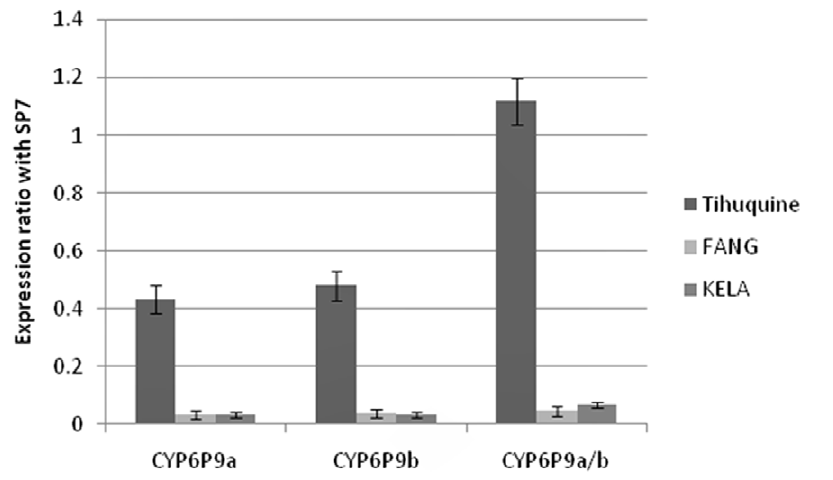
Figure 5. Relative expression levels of candidate genes using quantitative RT-PCR. Comparison of the patterns of gene expression of each copy of the duplicated CYP6P9 ( CYP6P9a and CYP6P9b ) and when both are amplified together ( CYP6P9a/b ) between the resistant field sample of Tihuquine, the laboratory susceptible strain FANG and KELA, a susceptible field sample from Mali. The normalised expression ratio of each gene against SP7 gene is represented on the vectical axis.